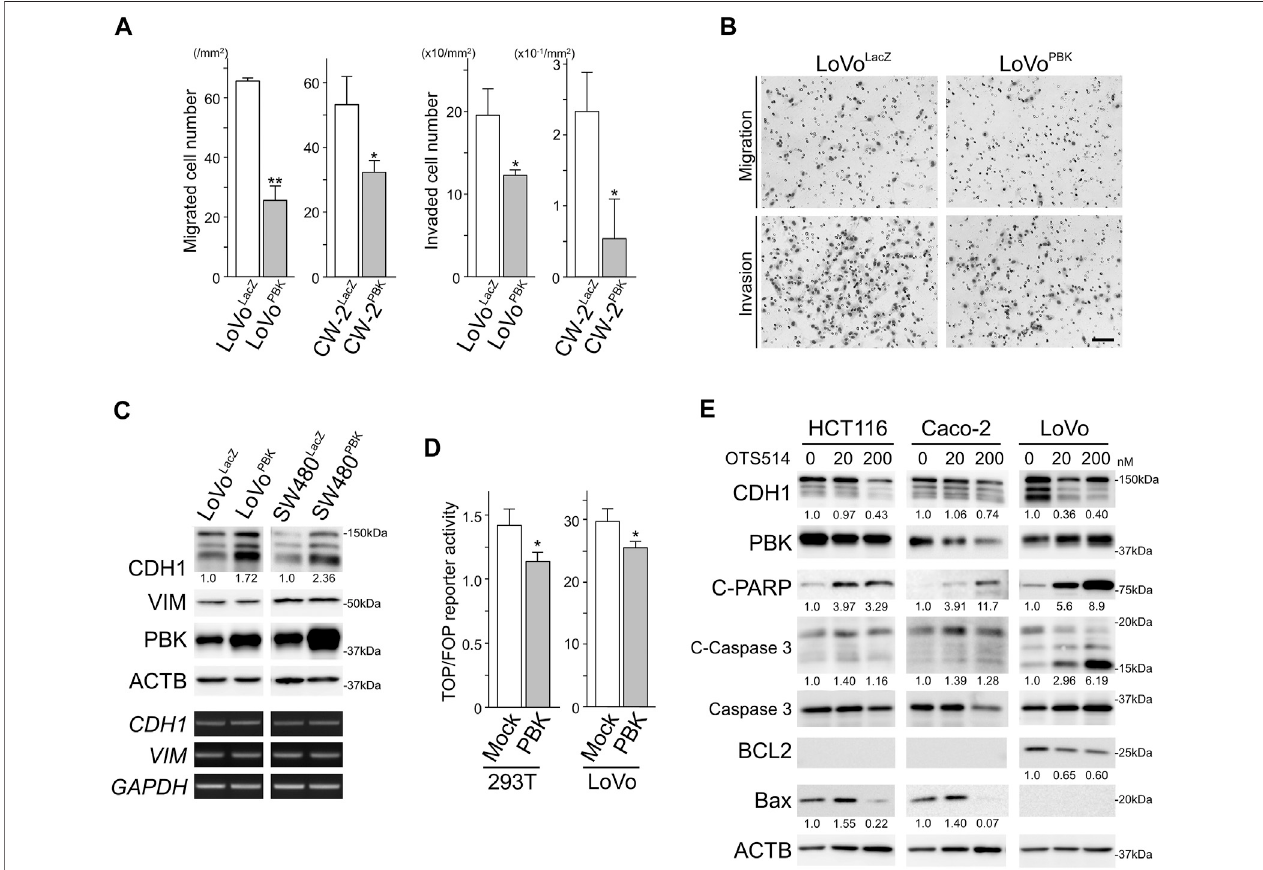
FIGURE 3 | PBK suppressed the migration and invasion of CRC cells with stabilizing CDH1. A and B , results of migration and invasion assays showing exogeneousexpressionofPBKsuppressedthemigrationandinvasionofCRCcells.Bar (cid:2) 100 µm.Assayswereperformedintriplicate.Dataareshownasmean ± S.D. *, p < 0.05, **, p < 0.01. (C) ,immunoblotand RT-PCR analysisshowing up-regulated CDH1without altering CDH1 inPBK inducedCRC cells. (D) , PBKsuppressed the TOP/FOP reporter activity in CRC cells. Assays were performed in triplicate. Data are shown as mean ± S.D. *, p < 0.01. (E) , protein expression of CDH1